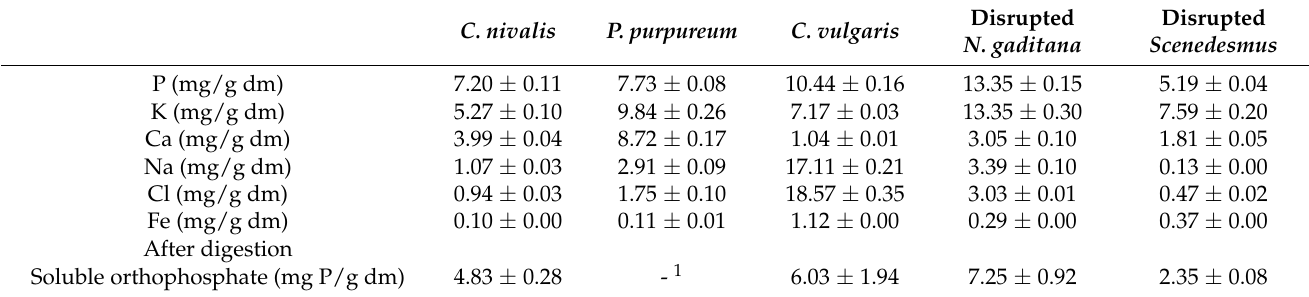
Table 4. Mineral concentrations of the initial biomass and soluble orthophosphate concentrations after